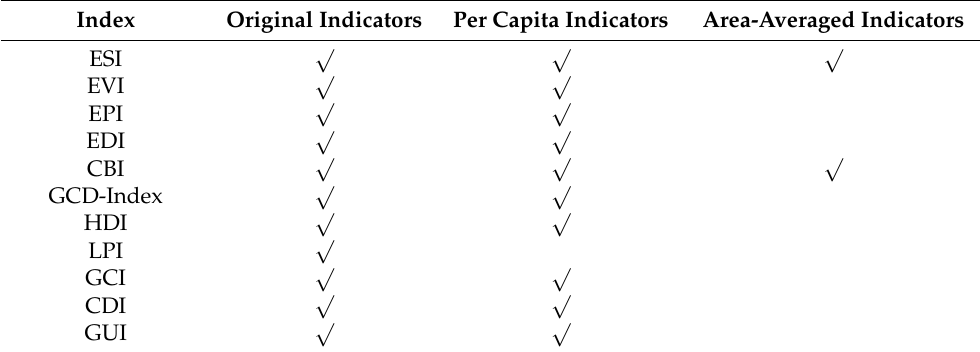
Table 1. City sustainability indices and indicator